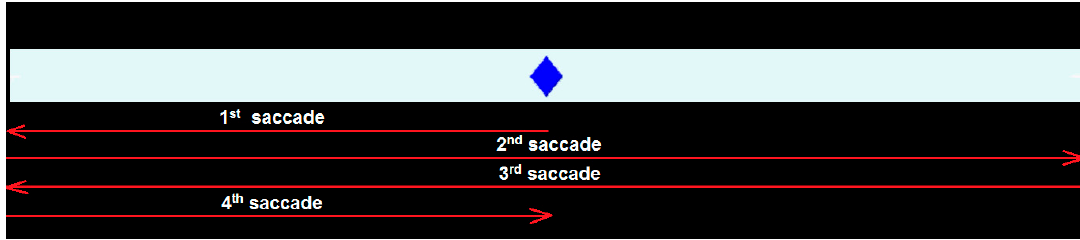
Sensors 2019 , 19 , x FOR PEER REVIEW 9 of 16 Figure 6. Graphical user interface of the software application developed. Figure 6. Graphical user interface of the software application developed.